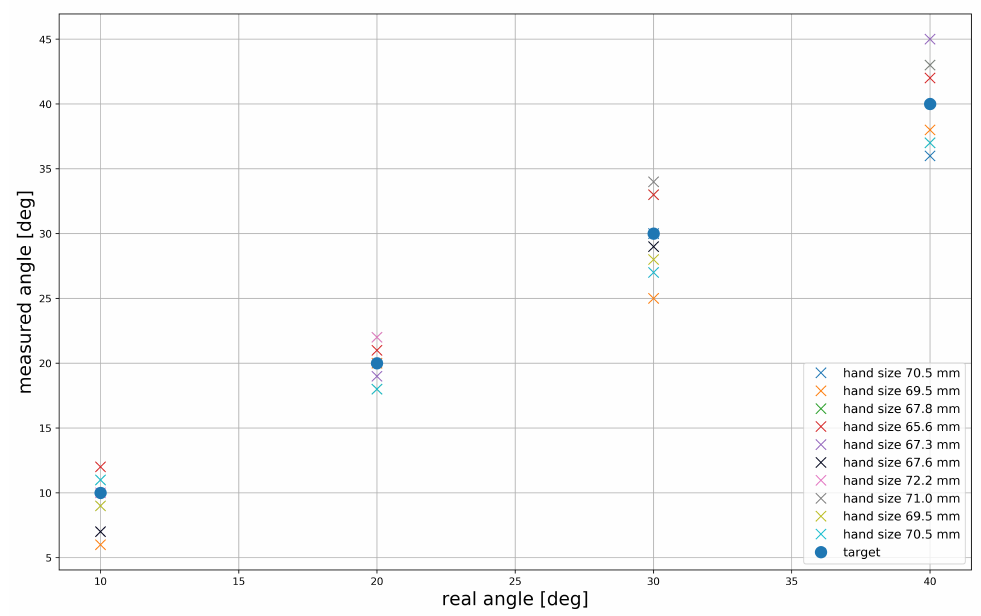
Figure 11. Mean error for adduction and abduction in terms of real angle and measured angle.